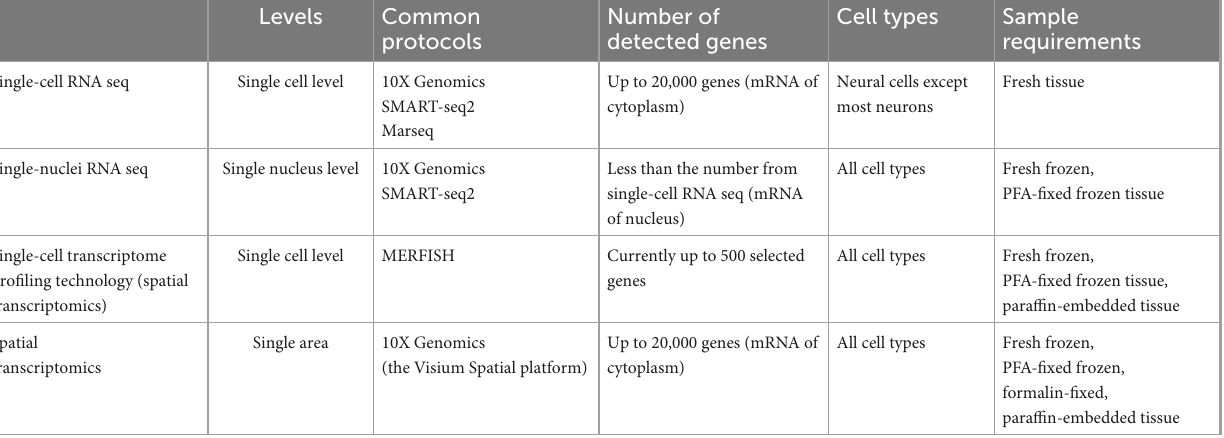
TABLE 1 Comparisons of different single-cell transcriptomic